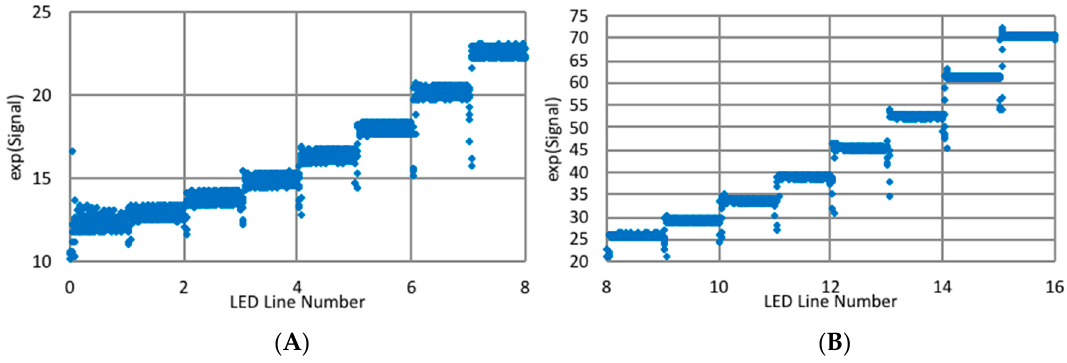
Figure 15. Signal (V) with corrections for rise/fall. ( A ) LED lines 0–8, and ( B ) LED lines 8–16.